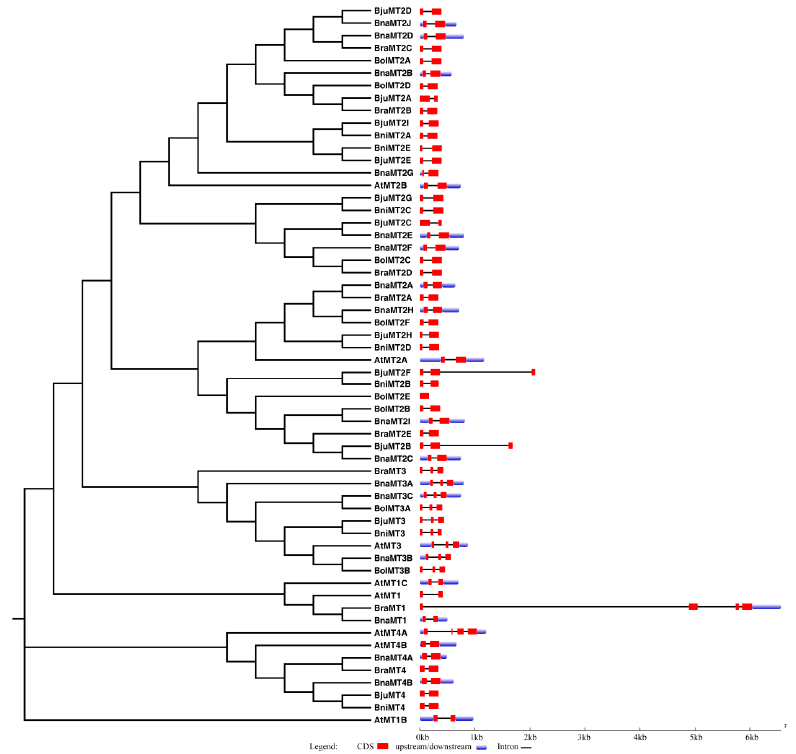
Figure 3. Phylogenetic relationships and genomic structures of the MT genes from A. thaliana and various Brassica species. The red boxes represent exons, solid lines represent introns (connecting two exons), and blue boxes represent untranslated regions (UTRs). The lengths of the MT genes are indicated by horizontal lines (kb).